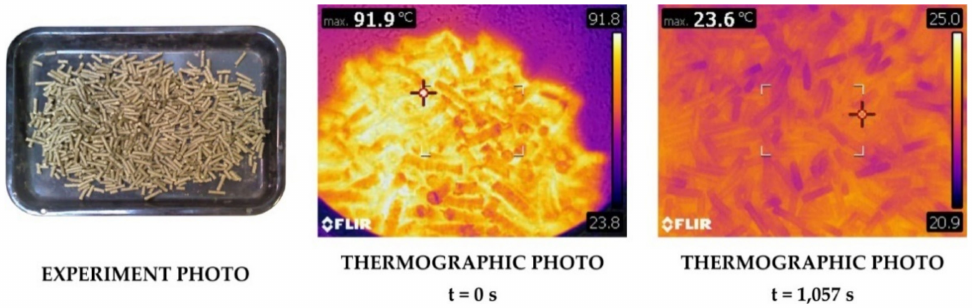
Figure 10. Thermographic photos made during spontaneous cooling on free surface.